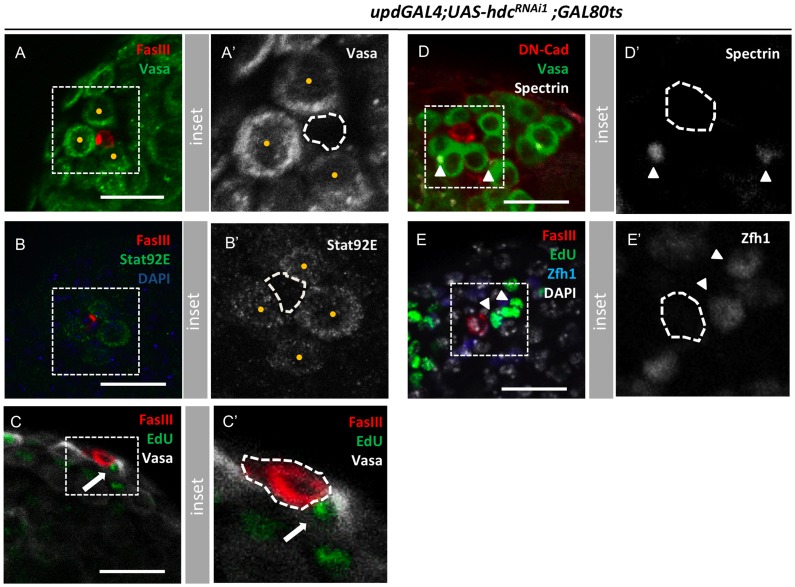
Smaller hubs are functional and capable of maintaining stem cells.(A, A’) Three Vasapos germ cells attached to a single cell hub (yellow dots in A’); FasIII (hub, red), Vasa (germ line, green). (B, B’) Four Stat92E+ GSCs (green in B, yellow dots in B’) around a 2 cell-hub. (C, C’) Dividing germ cell (white arrow) attached to a 2-cell hub. FasIII (hub, red), Vasa (germ line, white), EdU (green). (D, D’) Germ cells attached to a 1-cell hub with spherical fusomes (white arrowheads). DN-Cadherin (hub, red), Vasa (germ line, green), and α-spectrin (fusome, white). (E, E’) Two dividing Zfh1+ cyst cells (presumptive CySCs, white arrowheads) adjacent to a 2-cell hub. FasIII (hub, red), Zfh-1 (cyst cells, blue), Edu (green), DAPI (DNA, blue). Hub is outlined in all panels by a white dashed line. In all cases, testes are from updGal4;UAShdcRNAi1;Gal80ts males 10 days after shifting to 29°C to induce RNAi expression. Scale bars, 20 µm. See also Video S1 and S2.